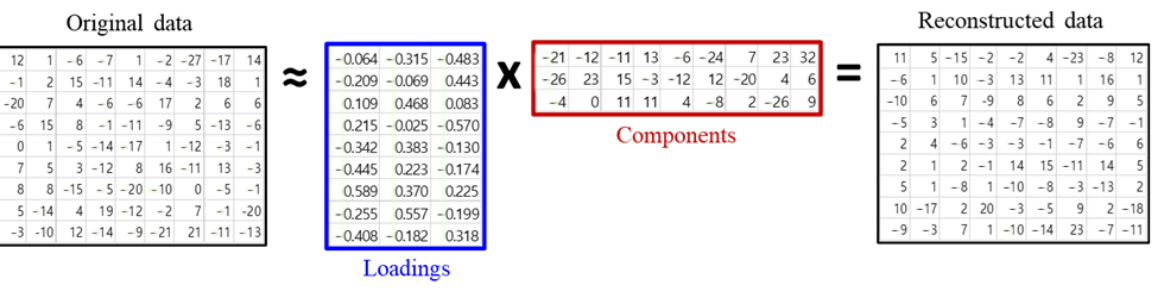
Figure 2. Original and reconstructed dataset in PCA Table 1. Comparison between supervised and unsupervised learning Supervised